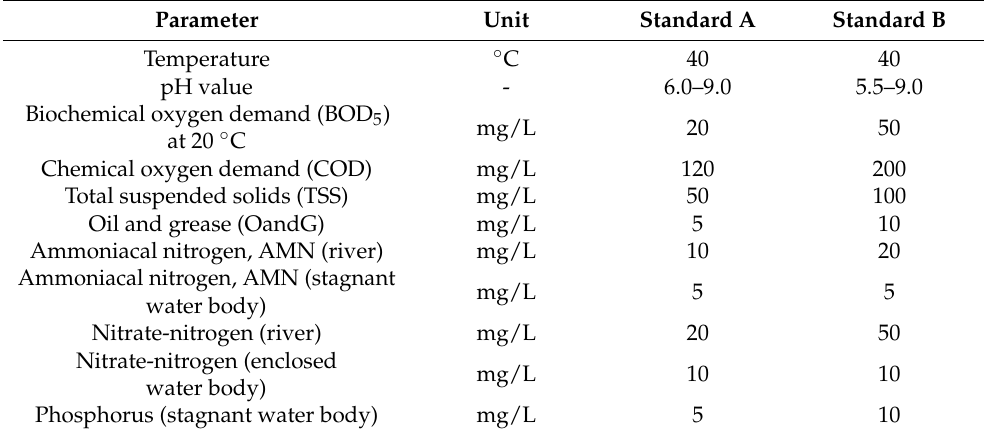
Table 2. Environmental Quality (Sewage) Regulation 2009 for new sewage treatment system